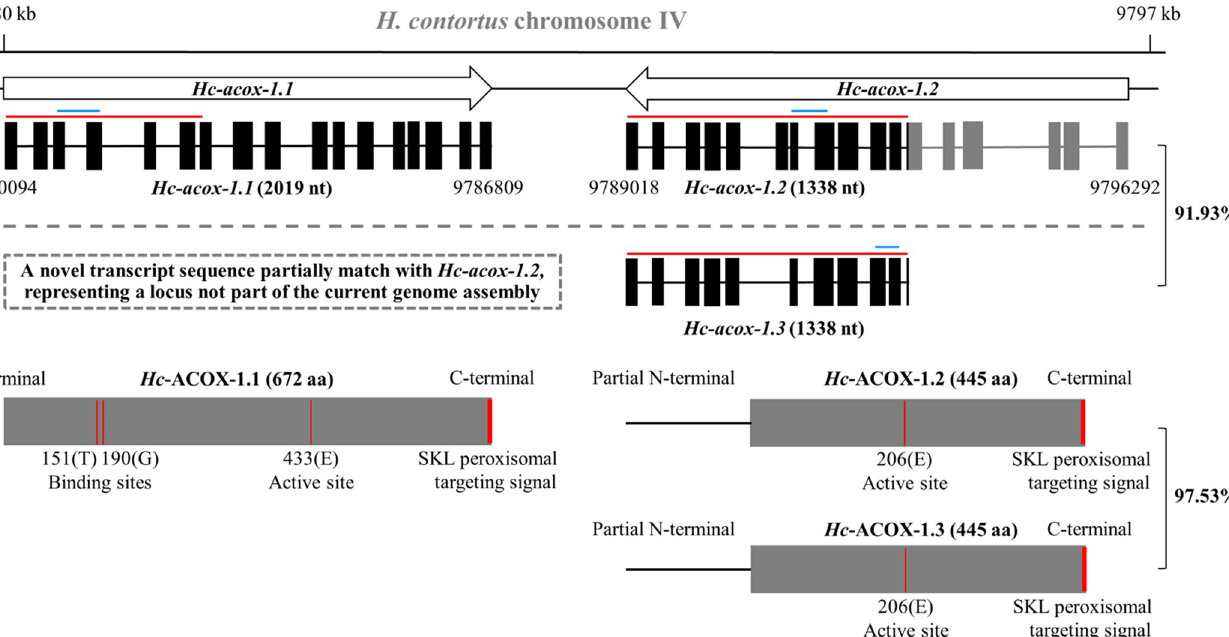
PLOS Pathogens| https://doi.org/10.1371/journal.ppat.1009767 July 16,